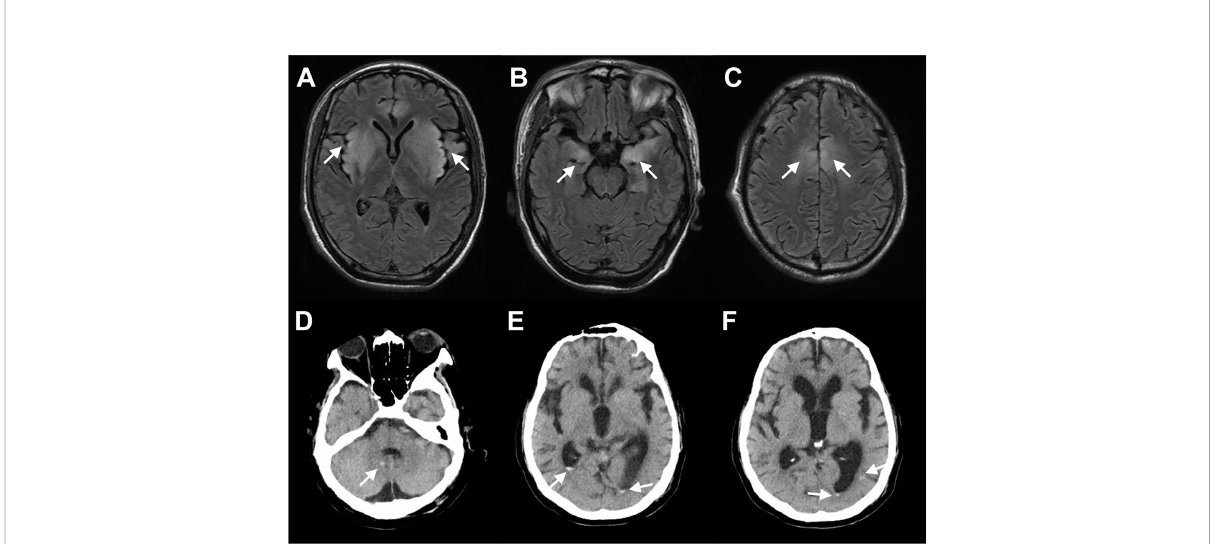
FIGURE 3 Selected Neuroimaging. (A – C) MRI of patient infected with Porcine herpesvirus 1 showed hyperintense signal distributed symmetrically in the bilateral insula lobe, the basal ganglia, the hippocampus, and the frontal lobe on T2 fl uid-attenuated inversion recovery (FLAIR). (D – F) CT of patient infected with Toxoplasma gondii showed multiple oval high-density shadows in the right cerebellar hemisphere, the posterior regions of bilateral ventricles, and the posterior corner of the left lateral ventricle. Arrows point to areas with enhanced